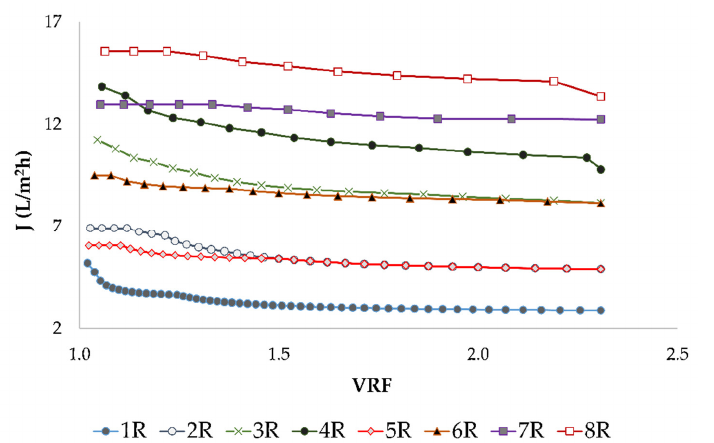
Figure 3. Influence of the volume reduction factor (VRF) on the permeate flux J (L/m 2 h) during the concentration of the conventional and ecological Cabernet Sauvignon red wines by reverse osmosis at 2.5, 3.5, 4.5 and 5.5 MPa, with and without cooling. Abbreviations: R—reverse osmosis process; 1—2.5 MPa, with cooling; 2—3.5 MPa, with cooling; 3—4.5 MPa, with cooling; 4—5.5 MPa, with cooling; 5—2.5 MPa, without cooling; 6—3.5 MPa,, without cooling; 7—4.5 MPa without cooling; 8—5.5 MPa, without